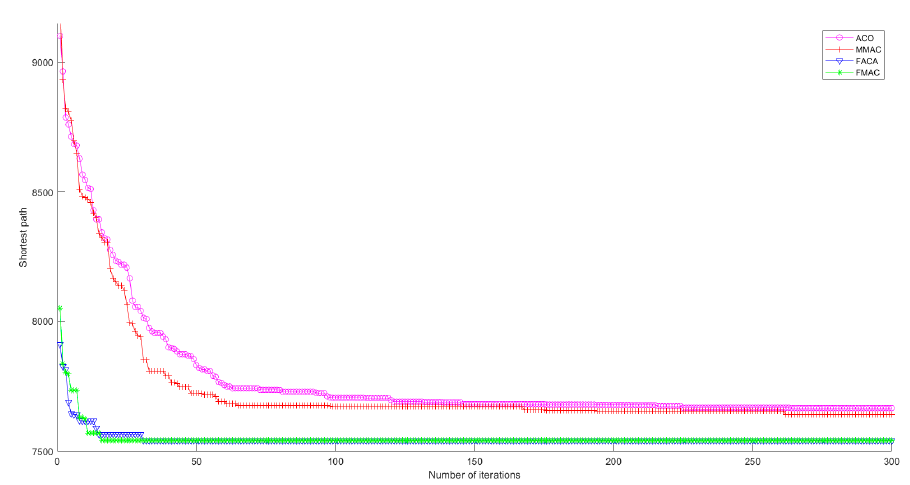
Figure 7. Average shortest path curve after each iteration in berlin52.